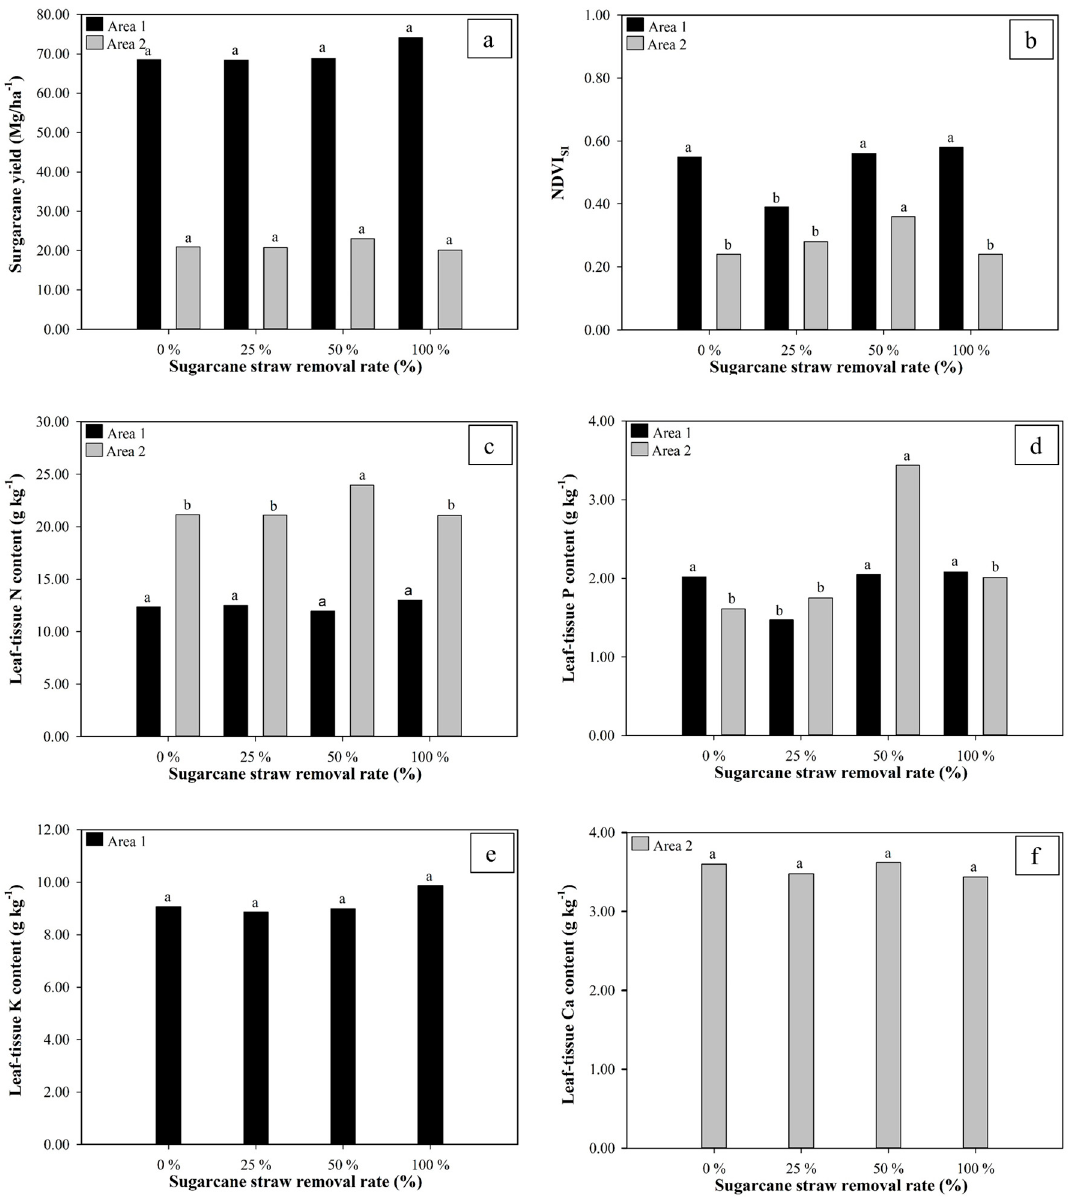
Figure 9. Comparison of the sugarcane straw removal rates with the variables selected by the stepwise model means. Sugarcane yield ( a ), the NDVI obtained from the satellite image data ( b ), leaf-tissue N ( c ), P ( d ), K ( e ), and Ca ( f ) contents in Areas 1 and 2. Means followed by the same letter are not statistically different by the Tukey test ( p ≤ 0.05).